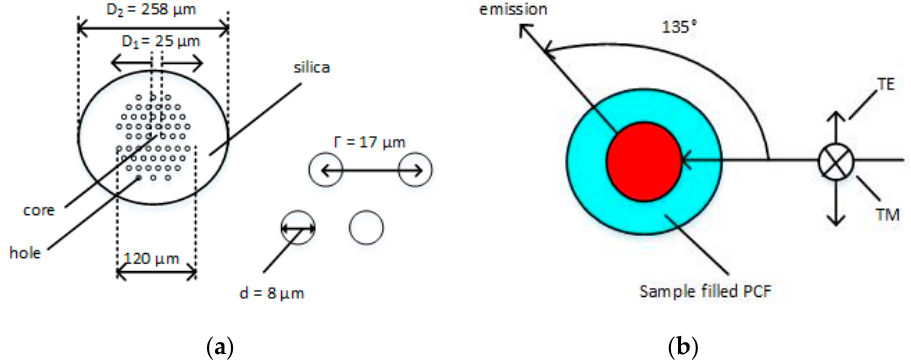
Figure 1. ( a ) Cross-section of the photonic crystal fiber (PCF); ( b ) optical setup for probing laser emission. TE, transverse electric; TM, transverse magnetic.